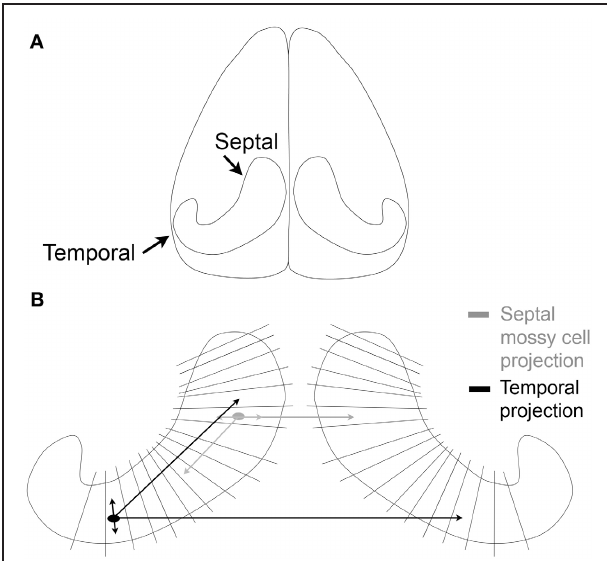
FIGURE 3 | The commissural/associational (C/A) pathway. (A) An illustration of the brain viewed from above shows the orientation of the hippocampus of the rodent. (B) The lamellae of the hippocampus are illustrated schematically. Mossy cells located near the temporal pole of the hippocampus (black) project to septal areas and to the temporal hippocampus contralaterally. The projections that are local terminate primarily in the hilus; the projections to distant lamellae terminate primarily on granule cell dendrites in the inner molecular layer. Mossy cells located in septal hippocampus (gray) have similar local and distant projections but the distant projection does not extend as far from the cell body as it does for temporal mossy